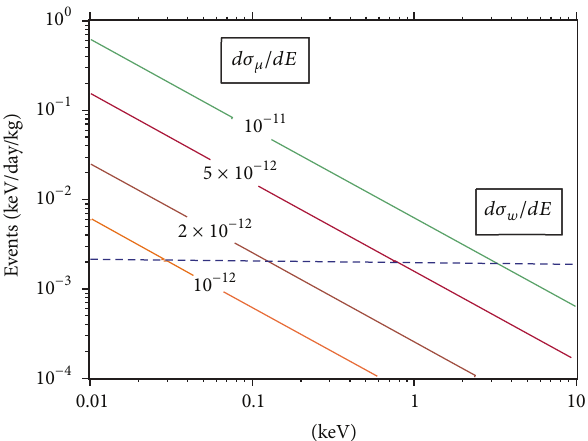
Figure 2: The count rate from CNNS as a function of energy of the recoiled nucleus for different gases. By dashed lines are indicated the count rates from neutrons generated by cosmic rays. The flux of antineutrinos is taken here 10 13 ] /cm 2